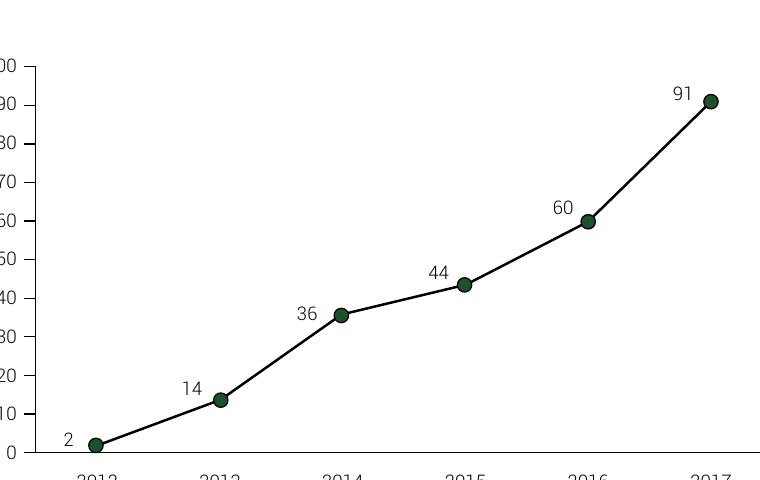
Figure 1. Number of lawsuits against dentists involving dental malpractice litigance, 2012-2017, São Paulo, SP, Brazil.